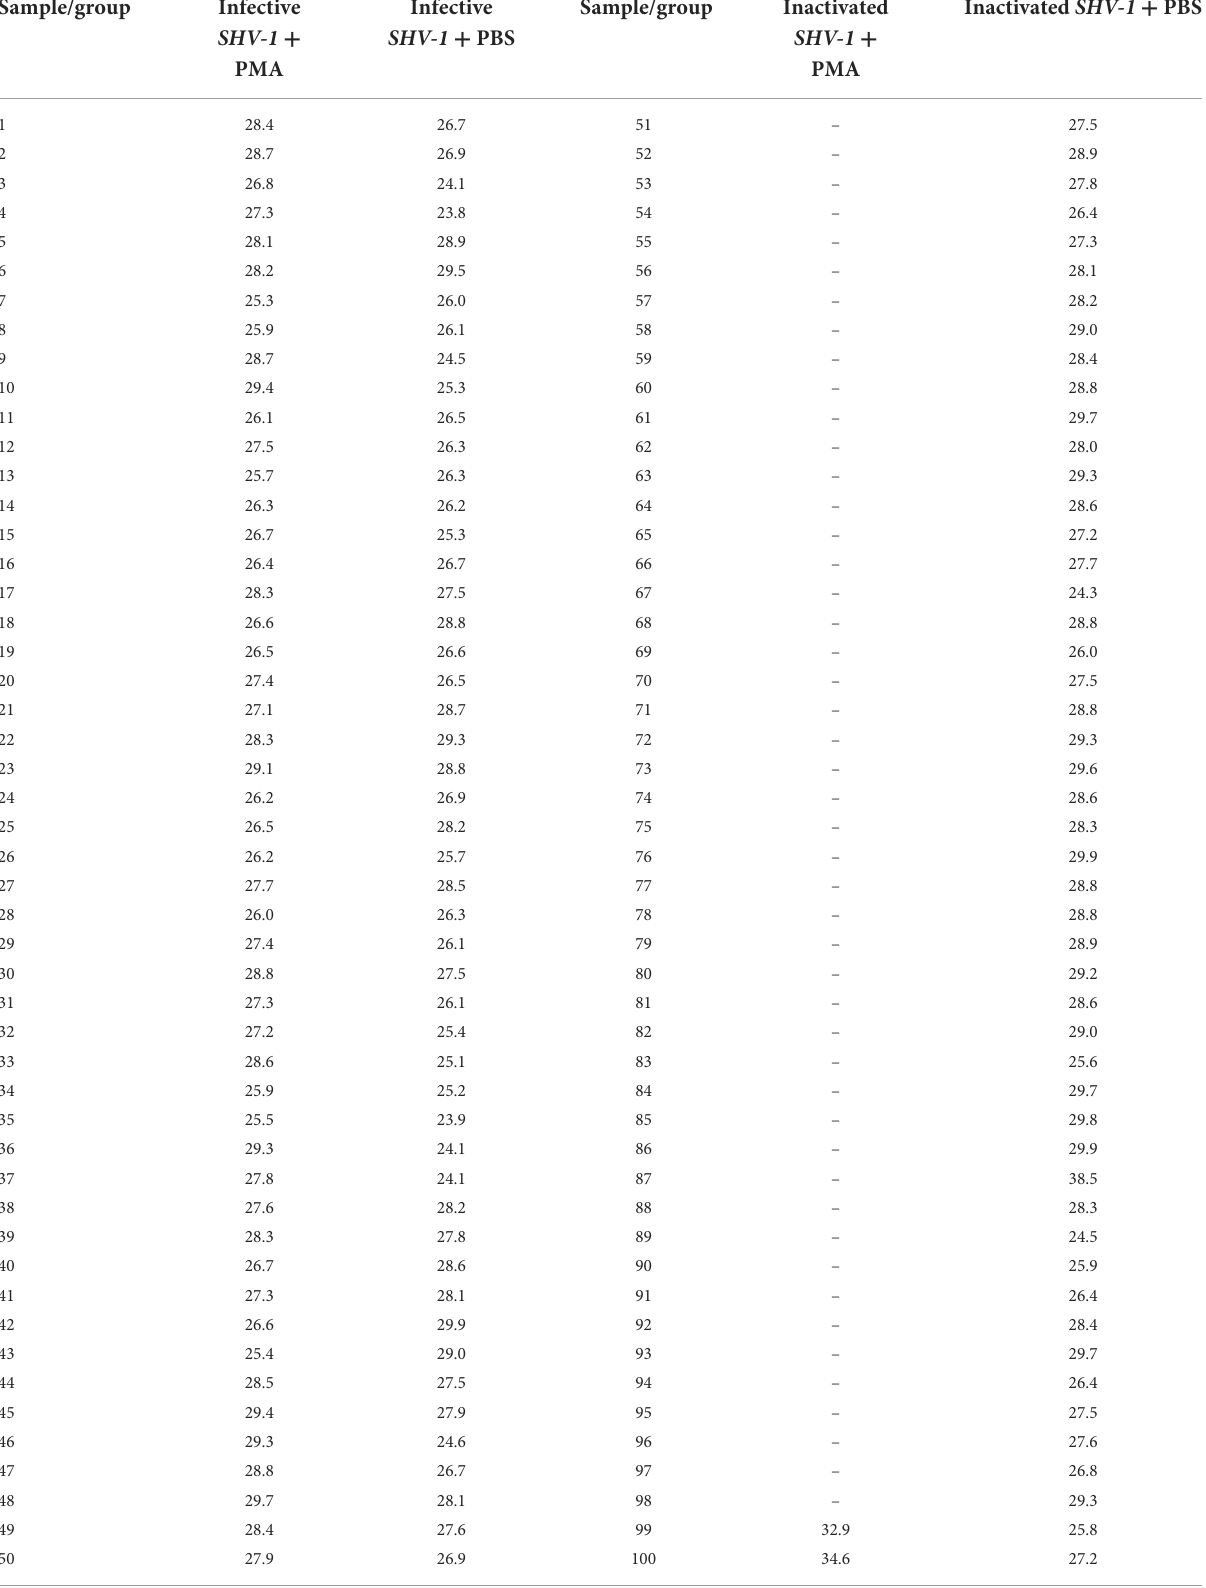
TABLE 6 Infectivity of SHV-1 detected using